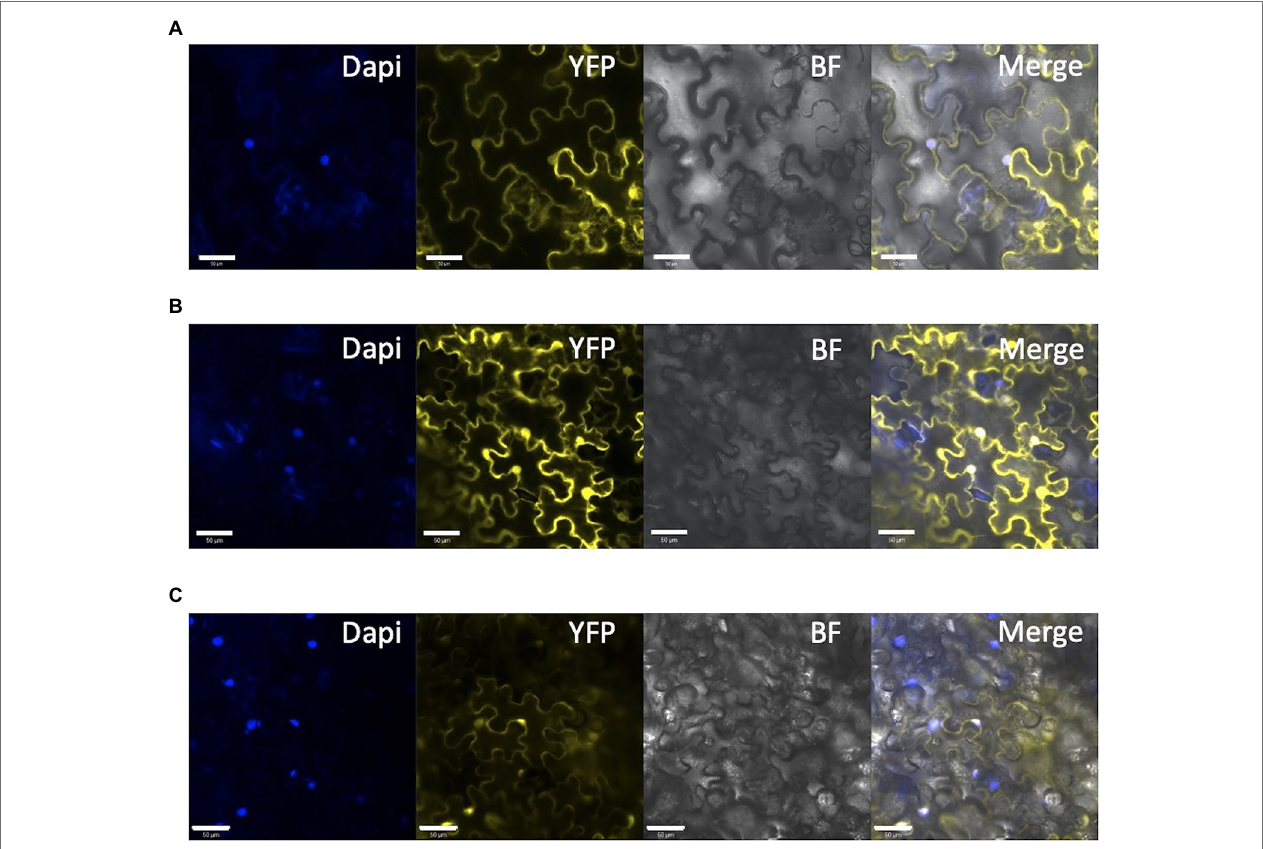
FIGURE 7 | Subcellular localization of mutated SlDET1 generated by Target-AID. (A,B) Confocal microscopy image of YFP-SlDET1 WT or mutated fusion protein in yellow; DAPI nucleus staining is shown in blue; BF represents the bright field image; and Merge show the merged image of the infected tobacco leaf. (C) 35S::YFP controlling transient expression in tobacco leaves. We noticed a strong protein signal in the cytoplasm and nucleus of the cell in both forms. White bars represent scale of 50 μ